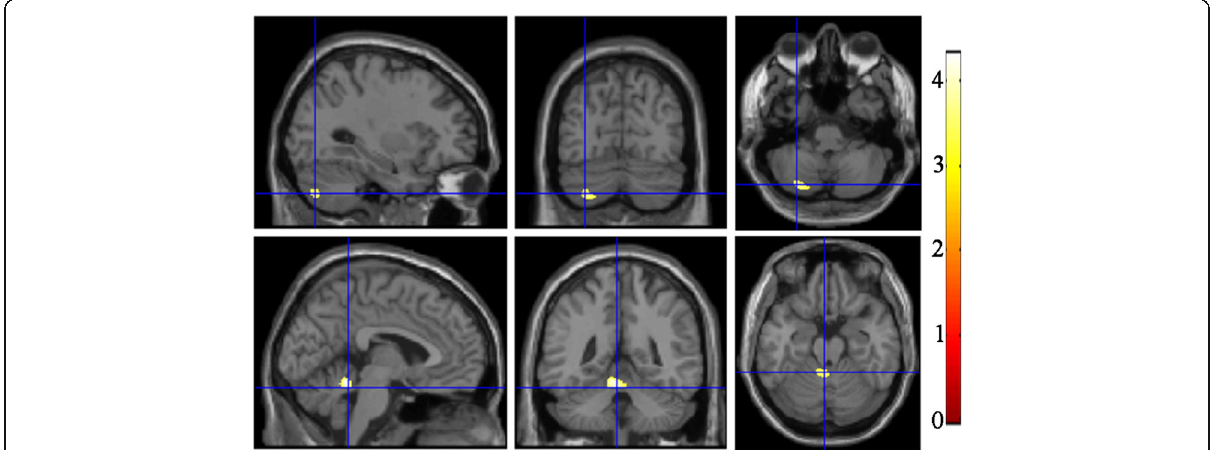
Fig. 3 The brain region with increased Contrast in the leftcerebellarCrus and Vermis in MOH compared with